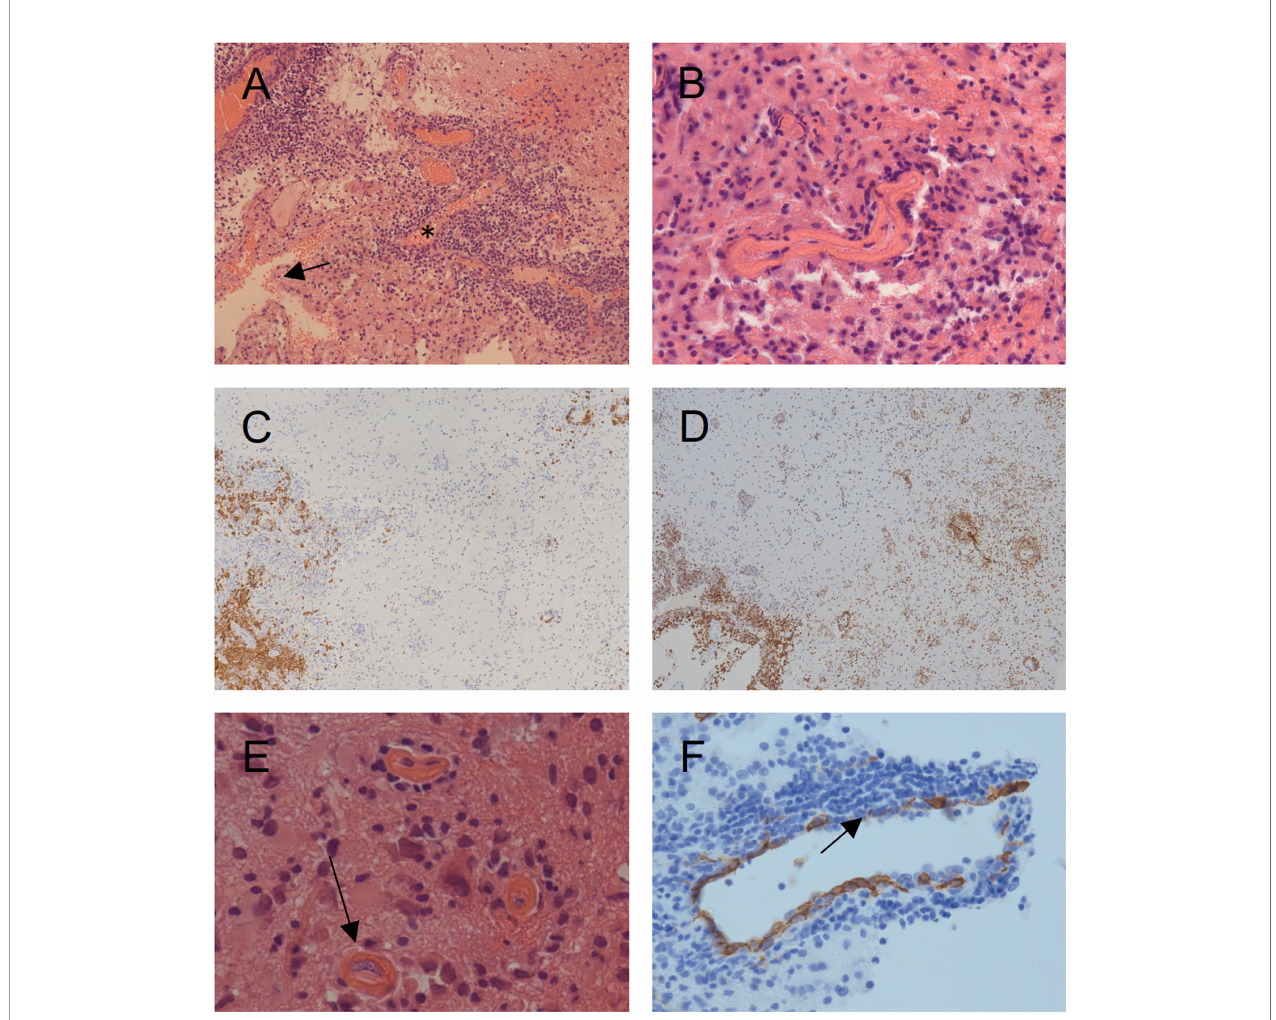
FIGURE 1 | Histopathologic fi ndings obtained by open surgery biopsy at age 8. (A) Hematoxylin and eosin (HE) staining showing diffuse lymphocytic in fi ltration involving the meninges (arrow), the vessels (asterisk) and the CNS tissue. (B) HE staining shows fi brinoid necrosis of the vessel walls with lymphocytic cell in fi ltrates. (C) Staining with a CD20 marker (brown) shows the distribution pattern of B-cells, primarily restricted to the meninges and the vessel walls. (D) Staining with a CD8 marker (brown) shows the distribution pattern of CD8 + T-cells with diffuse in fi ltration of the meninges, the vessel walls and the brain parenchyma. CD3 + T-cells showed a similar distribution pattern (data not shown). (E) Thrombotic occlusive vasculopathy (arrow) is shown. (F) CD34 staining of the vessel endothelia shows thin and fragmented endothelia (arrow) with partially thrombosed vessels, indicating severe vascular